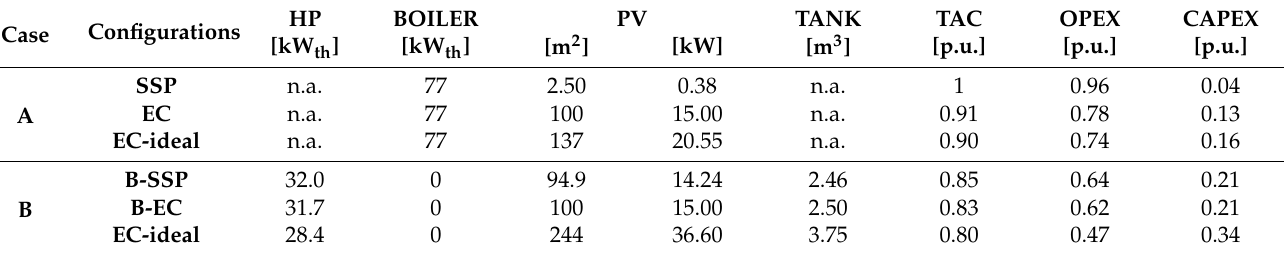
Table 6. Sizes of installed energy systems for each scenario and